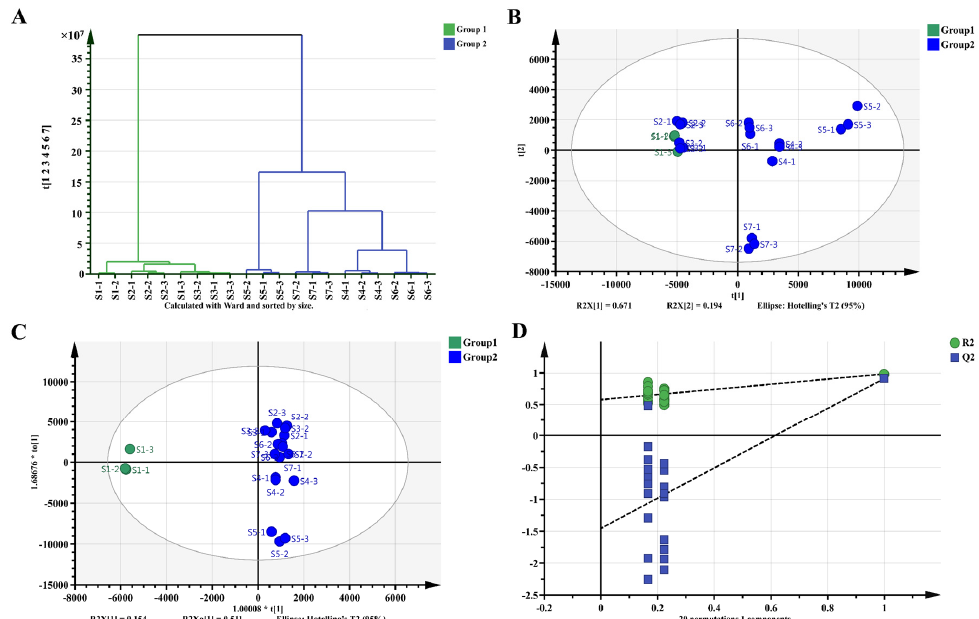
Figure 5. Multivariate analysis of seven FBT samples. ( A ) Dendrogram plot of tea samples. ( B ) PCA score plot, R2X = 99.0%, Q2= 96.6%. ( C ) OPLS-DA score plot, R2X = 97.1%, R2Y = 98.6%, Q2= 91.4%. ( D ) Permutation plot of OPLS-DA, with intercepts of R2=0.579, Q2 = − 1.46. Furthermore, based on OPLS-DA with good pairwise discriminations and the cutoff VIP value (VIP > 1.0), a total of 34 critical metabolites were selected to visualize the dy- namic changes during FBT processing (Table 3). The content variation of the critical me- tabolites between samples was represented by the depth of the colors shown in Figure 4B.